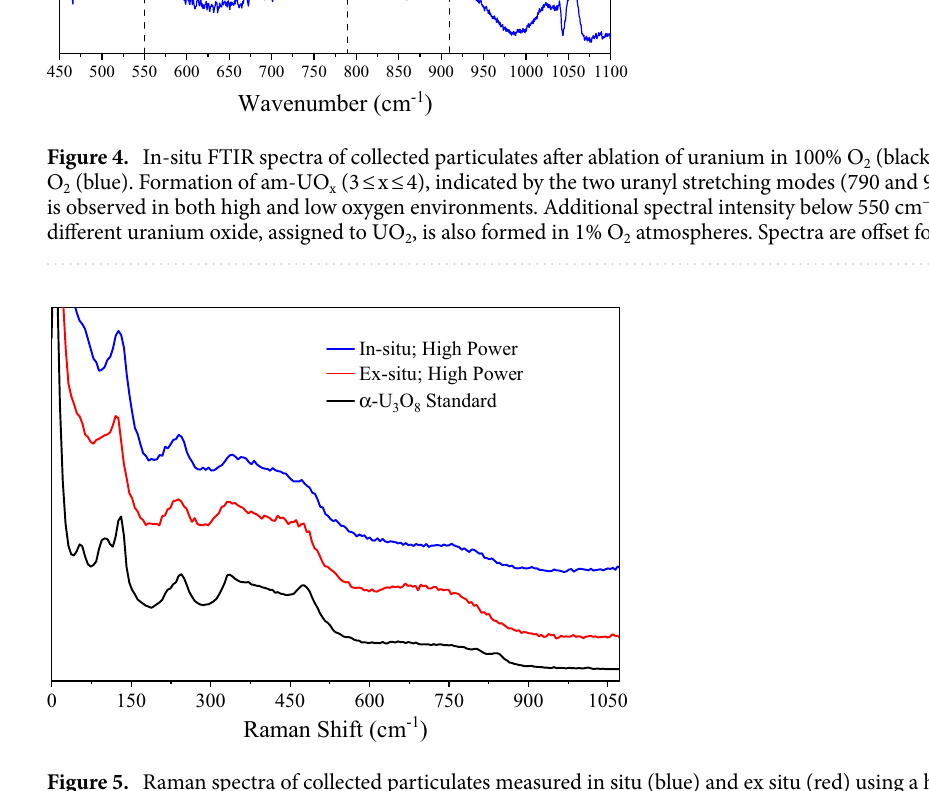
Figure 5. Raman spectra of collected particulates measured in situ (blue) and ex situ (red) using a high HeNe power. Also shown is the spectrum measured from an α-U 3 O 8 standard (black). Spectral similarities at ~ 125, 240, and 295–520 cm −1 suggest that a higher power HeNe beam can convert am-UO x particulates to α-U 3 O 8 . Spectra are offset for